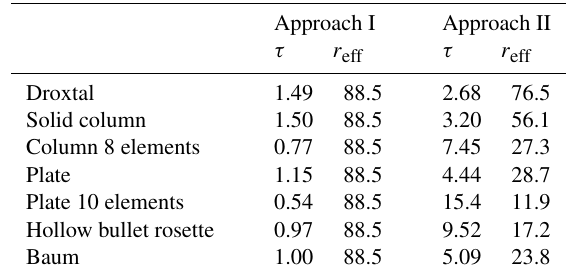
Table 1. Optical thicknesses at λ = 550nm and effective radii (µm) for a cirrus between 6.7 and 8.5km altitude assuming different ice crystal shapes for approach I (constant number size distribution) and approach II (constant ice water